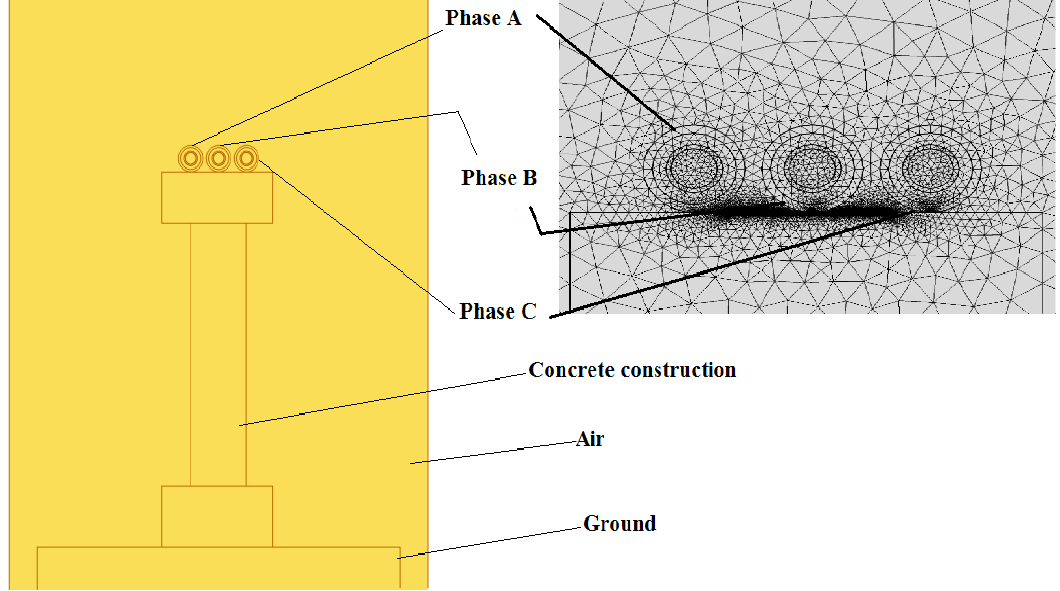
Figure 4. View of the model calculation range and a fragment of the applied mesh in terms of laying cable lines on the concrete